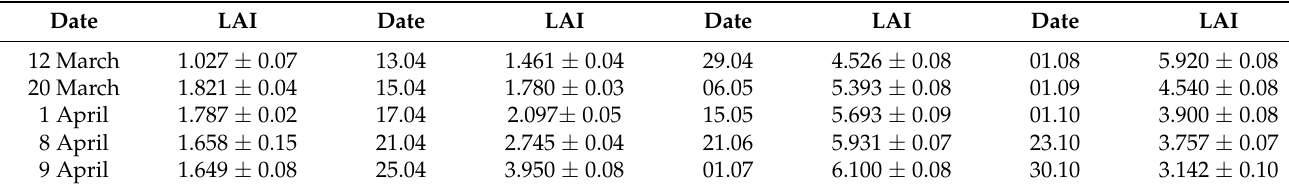
Table 3. Measured values of the LAI (m 2 · m − 2 ) with the standard